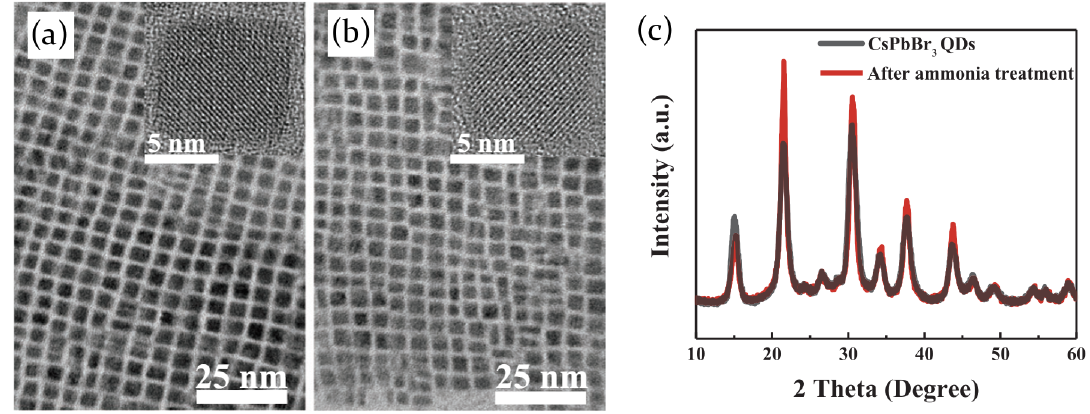
Figure 11. TEM images of CsPbBr 3 QDs ( a ) before and ( b ) after ammonia gas exposure. ( c ) XRD pattern of CsPbBr 3 QDs before and after NH 3 treatment. Adapted with permission from [86]. Copyright © 2020, WILEY-VCH Verlag GmbH and Co. KGaA,